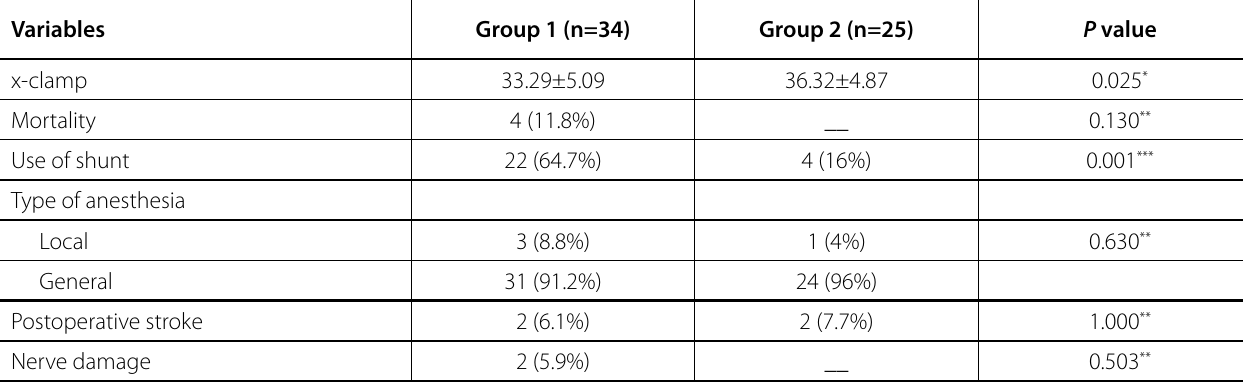
Table 3. Operative